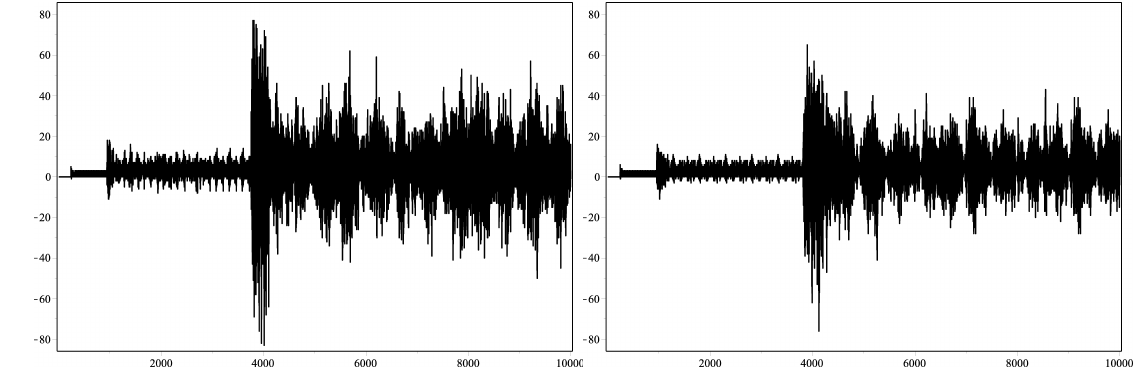
Fig. 4. Line graphs of S 59,4 ( n ) and S 60,4 ( n ) for n ≤ 10 4